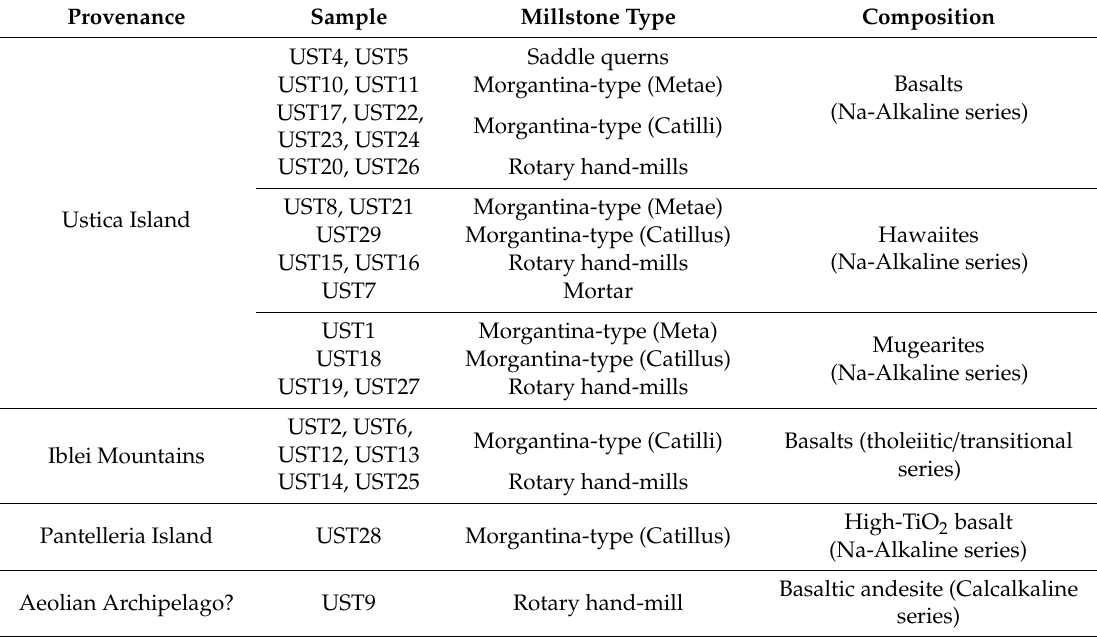
Table 5. Provenance, millstone type and composition of the investigated